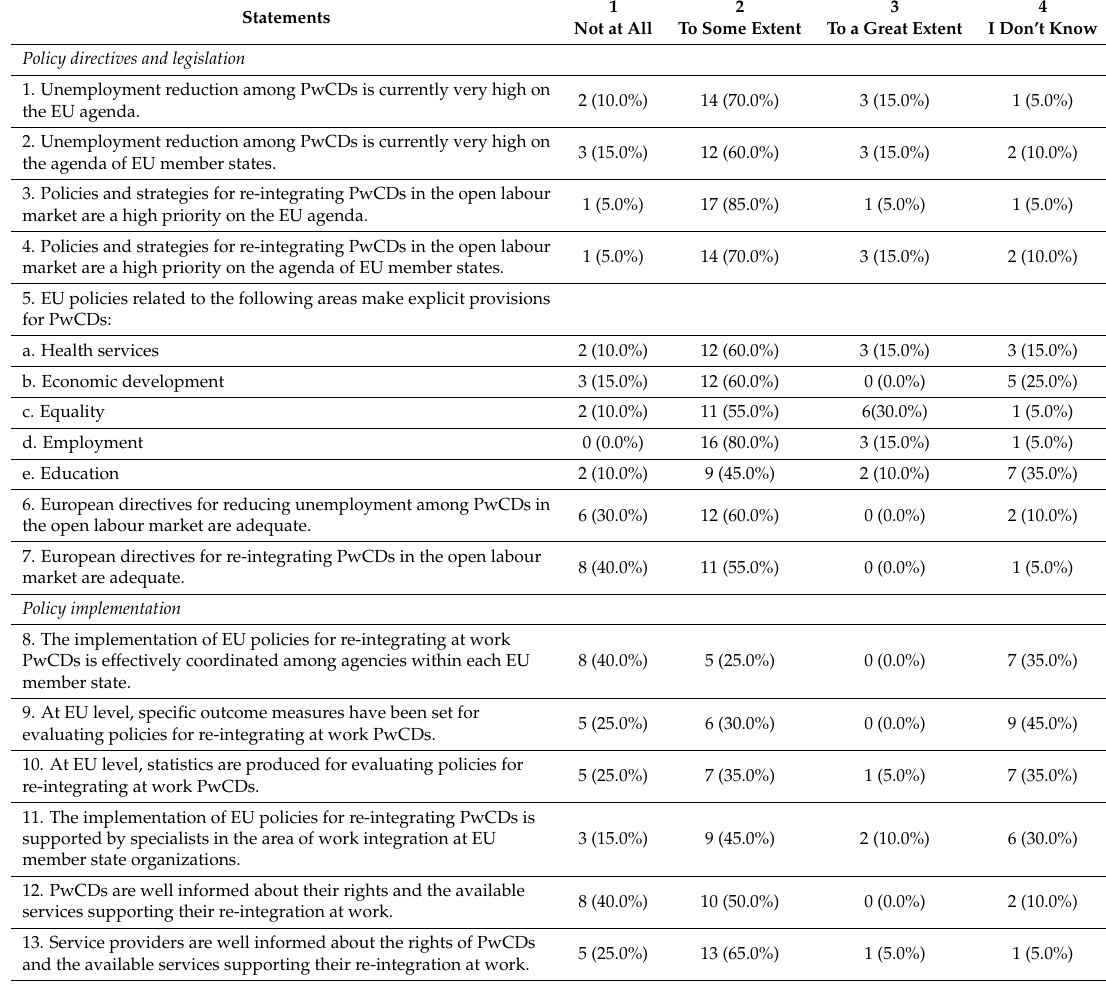
Table 3. Views of European stakeholders on the conceptualization and implementation of employment re-integration policies and